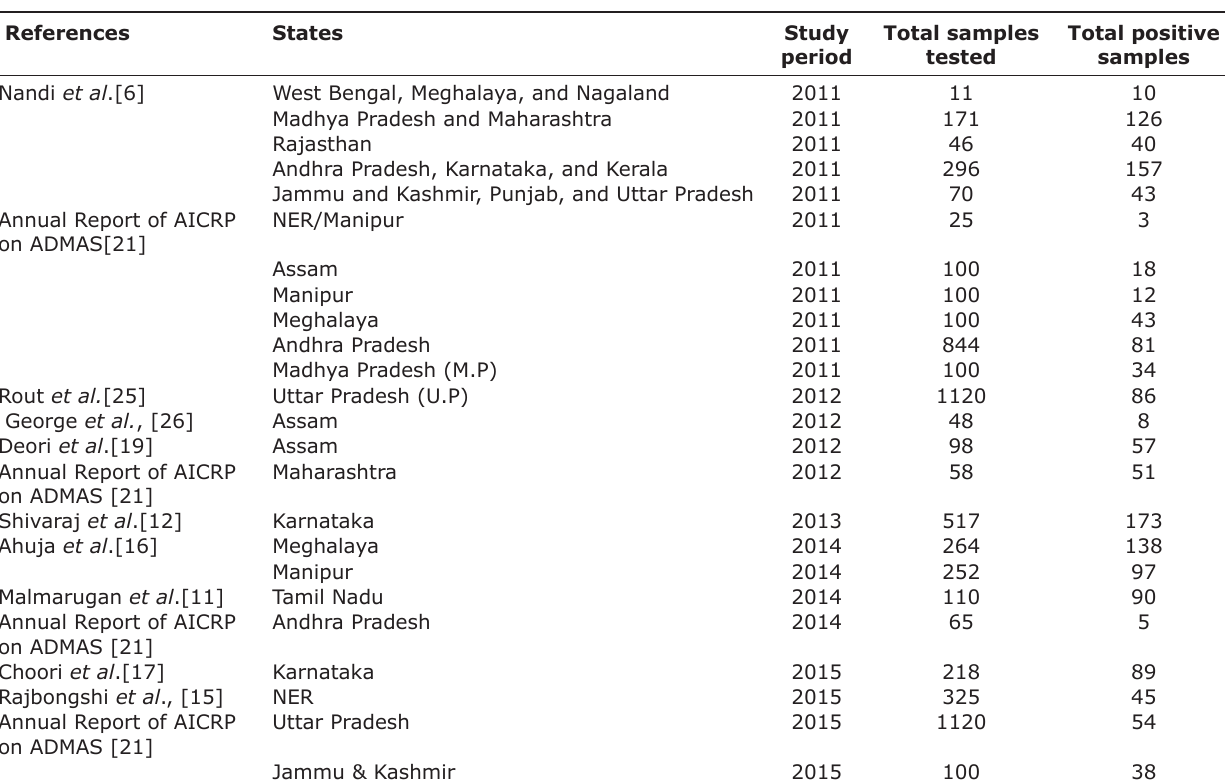
Figure-1: The flow diagram of paper review process (one article may contain 1/more studies). Table-1: Characteristics and data summaries of the publications included in the